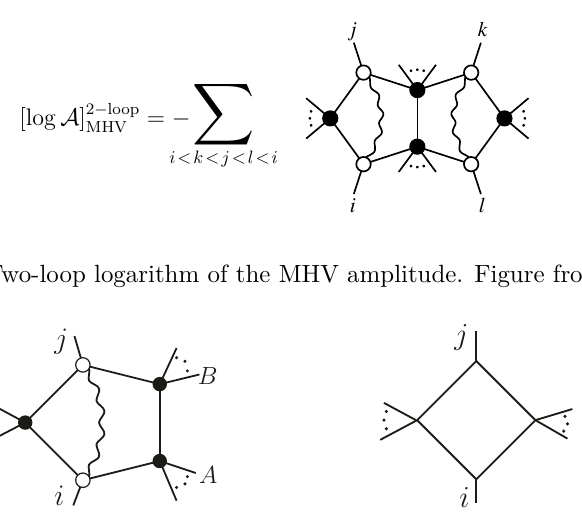
Figure 4 . The chiral pentagon one-loop integral I cp two-mass easy configuration F 2me